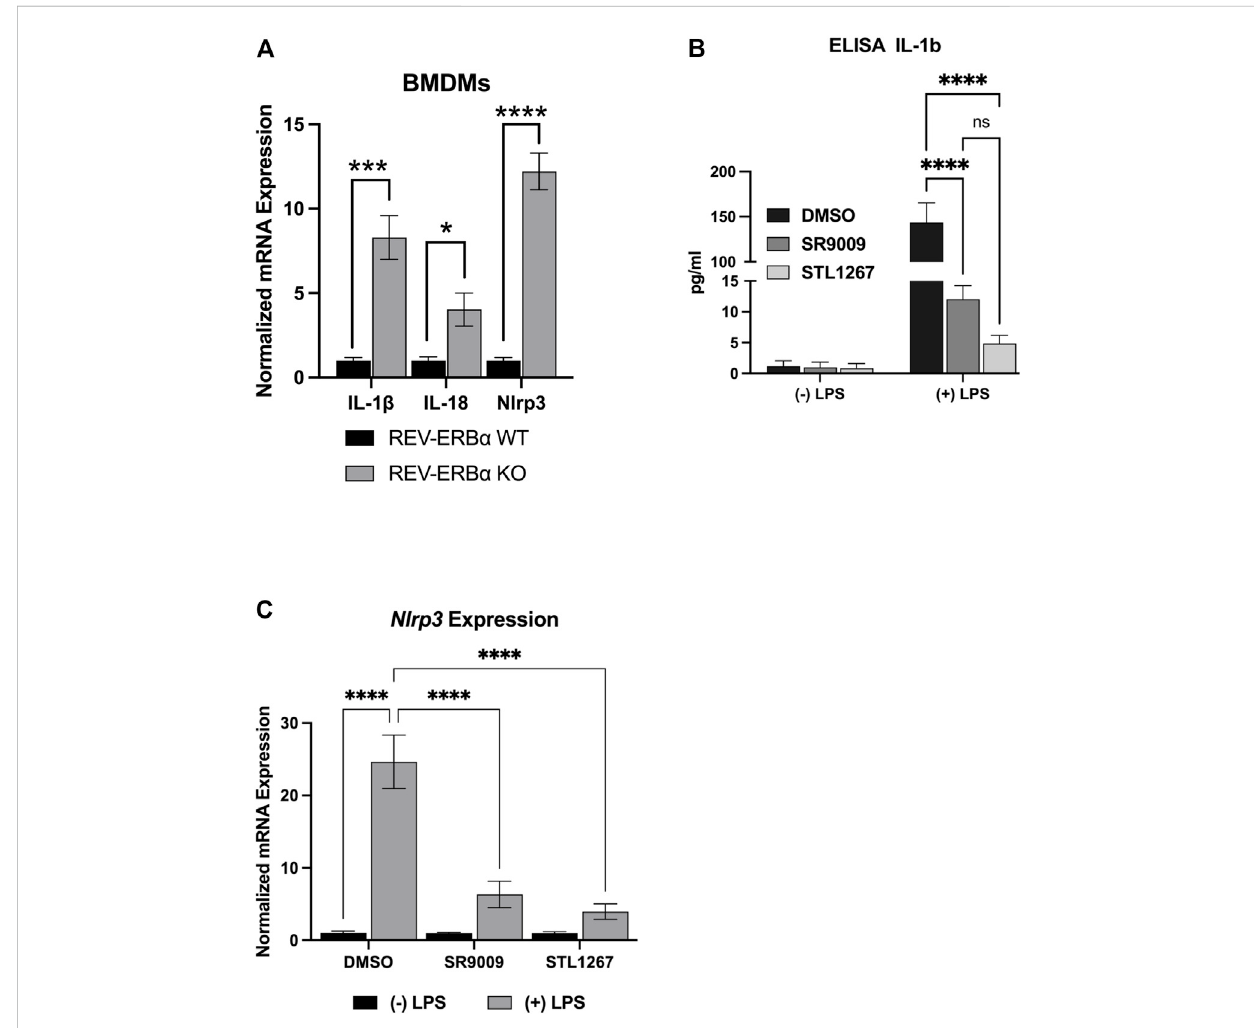
FIGURE 2 In vitro model of REV-ERB anti-in fl ammatory actions. (A) Mouse bone marrow-derived macrophages from Nr1d1 − / − ( n = 7) and wildtype ( n = 12) mice.Bothmaleandfemalemicewereusedforthisstudyandnosex-speci fi cdifferenceswerenoted. (B) IL-1 β ELISAresultsfordifferentiatedThp-1cells. (C) NLRP3 gene expression results of the differentiated Thp-1 cells. Results were graphed and analyzed in Graphpad Prism by ANOVA and represented as Mean ±